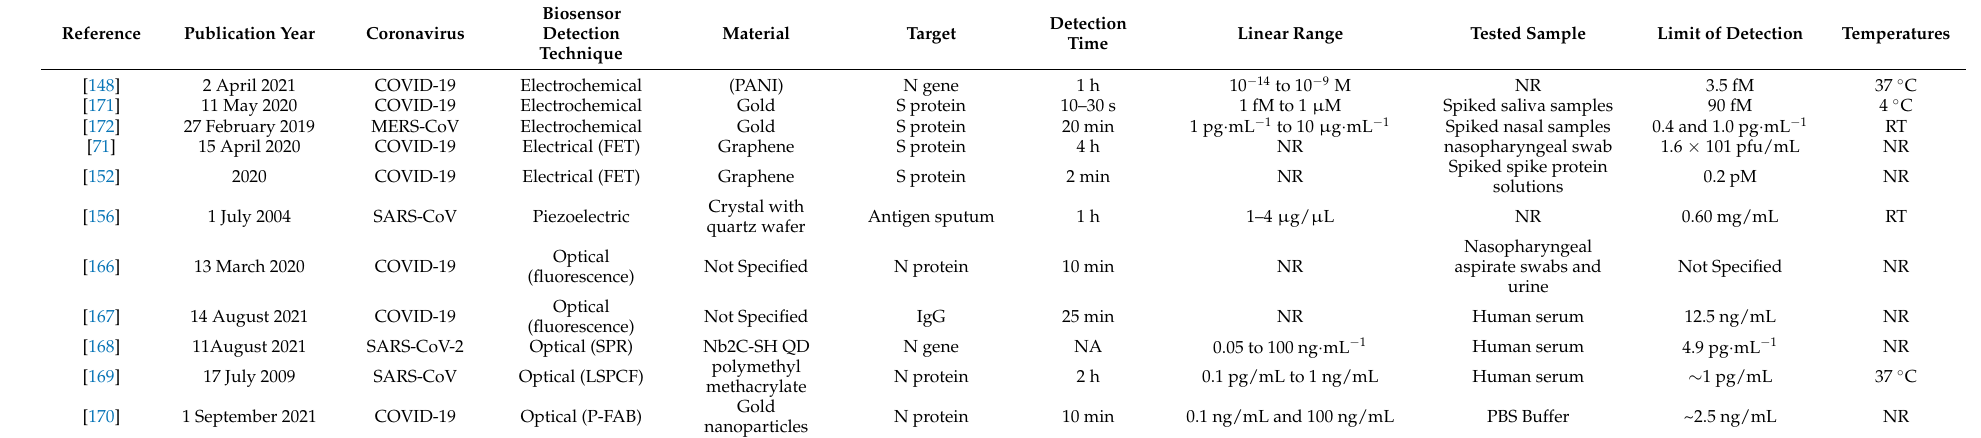
Table 4. Coronavirus detection methods analysis based on biosensor